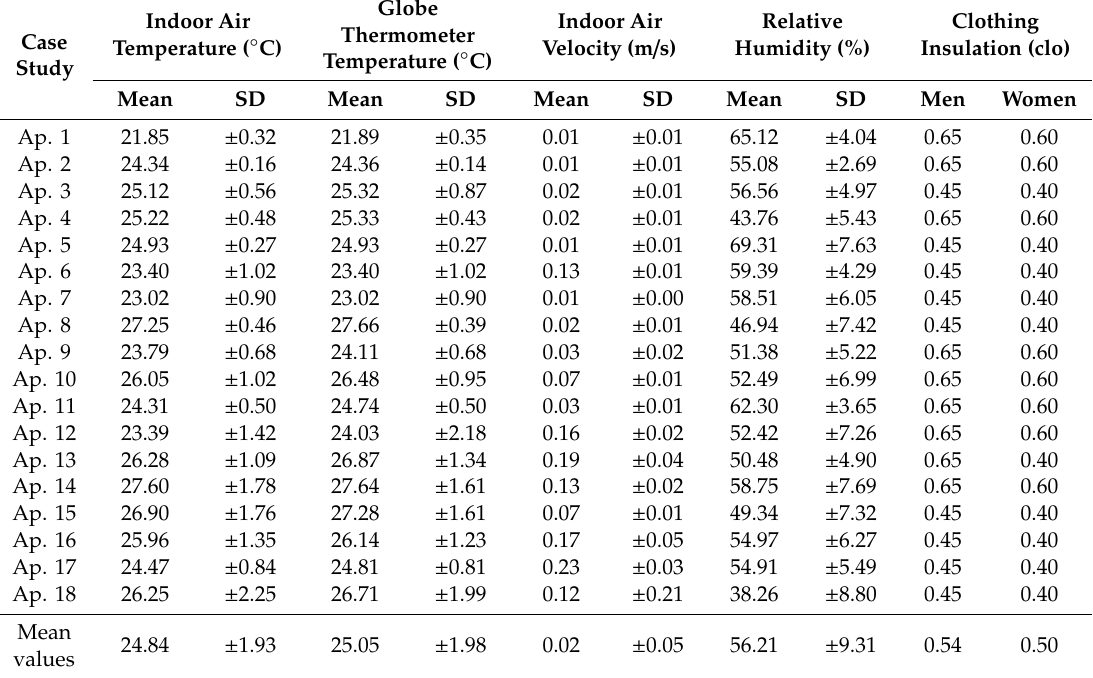
Table 3. Mean values and standard deviation (SD) of the main monitored variables and clothing insulation